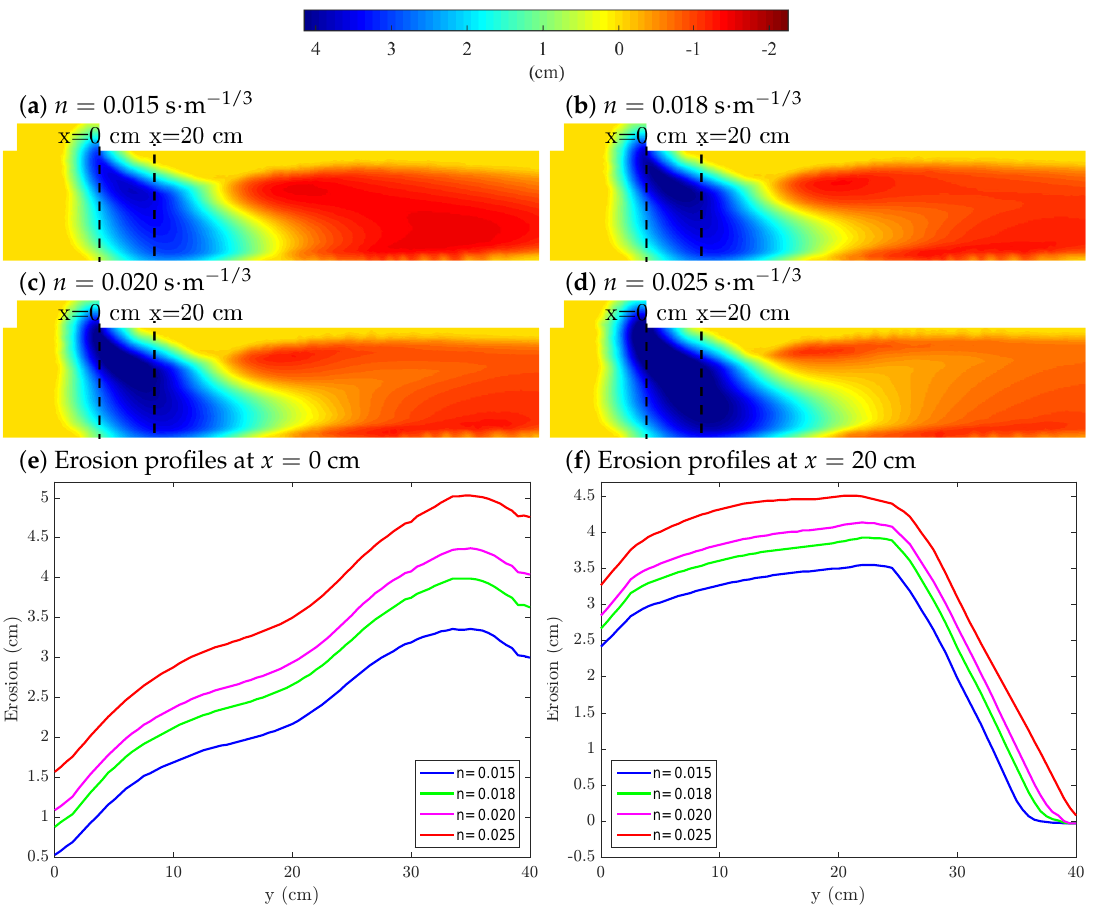
Figure 7. Effect of roughness on the erosion pattern. We plot the erosion contour plot for four Manning’s coefficients, n : in panel ( a ) n is 0.015 s · m − 1/3 , in panel ( b ) n = 0.018 s · m − 1/3 , in panel ( c ) n = 0.020 s · m − 1/3 , and in panel ( d ) n = 0.025 s · m − 1/3 . We plot two erosion profiles of the main channel at x -coordinate 0 cm in panel ( e ) and x = 20 cm in panel ( f ). The reference system is